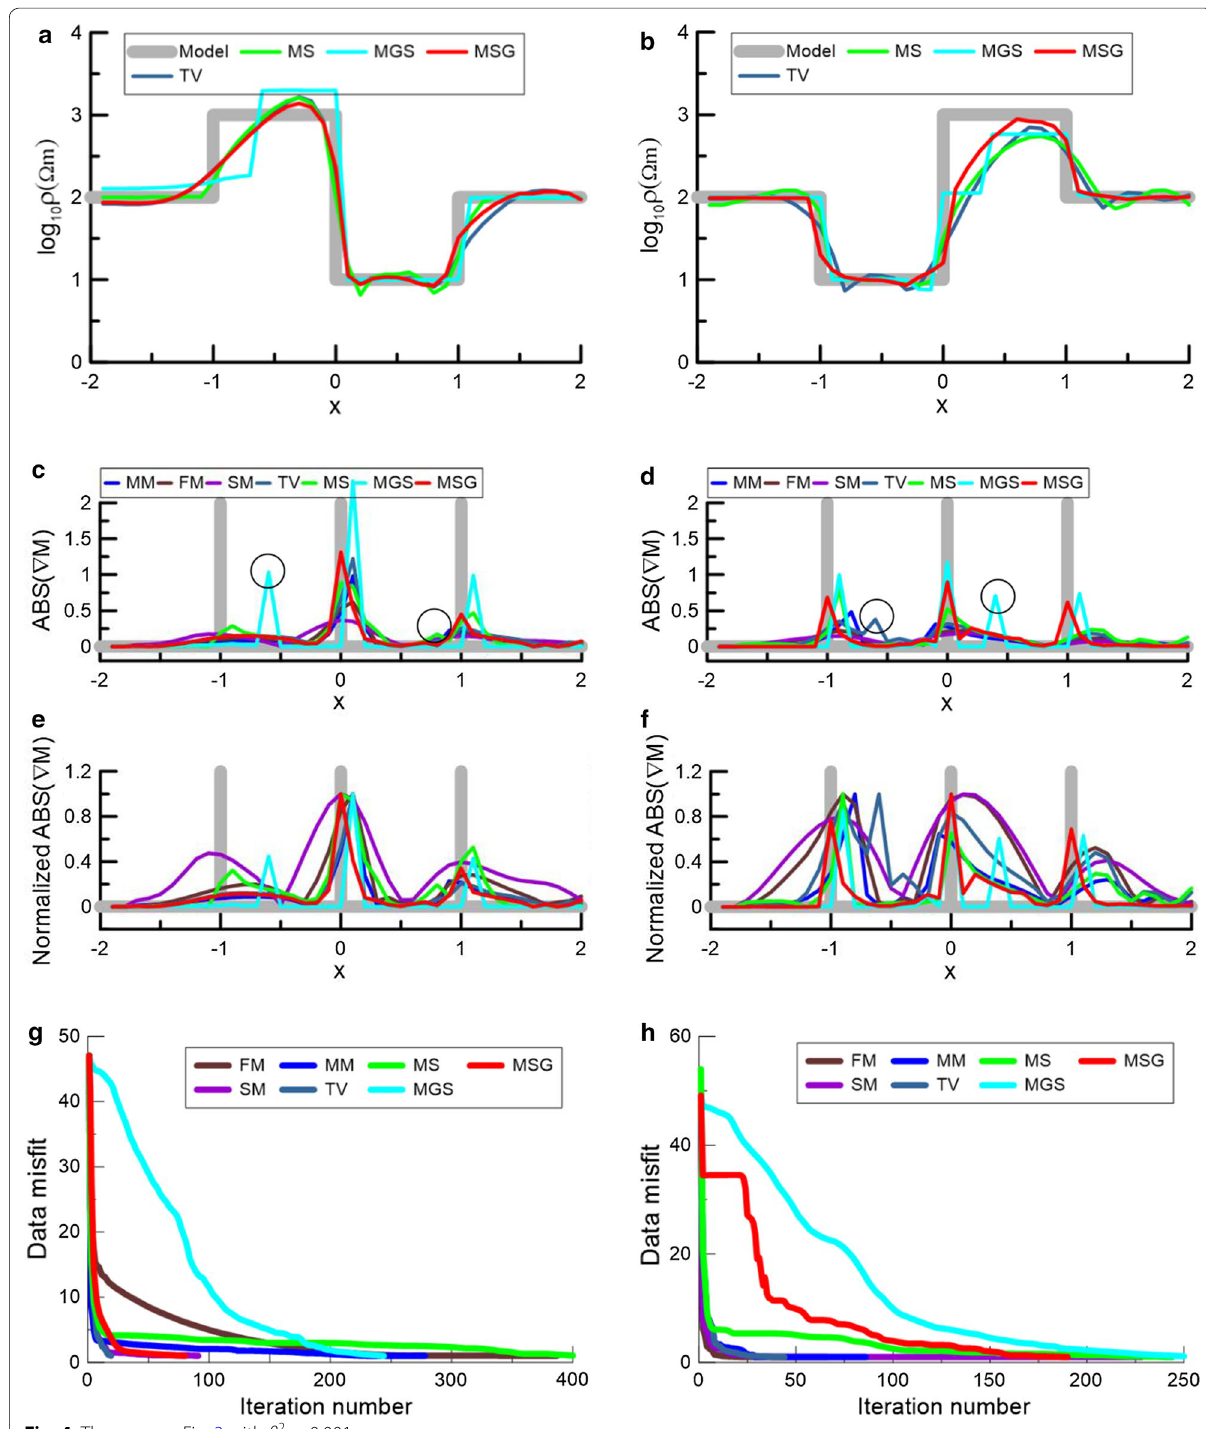
Fig. 4 The same as Fig. 3 with β 2